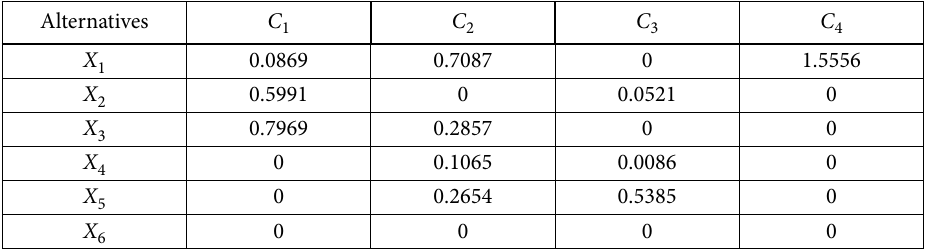
Table 9. The PDHFPDA matrix Alternatives